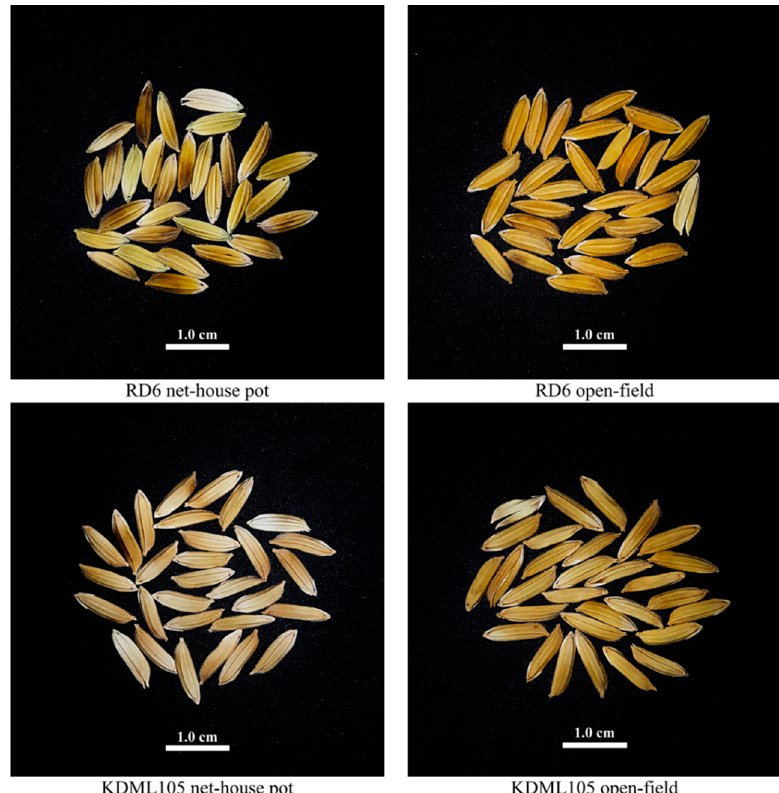
Figure 1. Representation of the grain appearances of two Thai elite rice cultivars grown in the net-